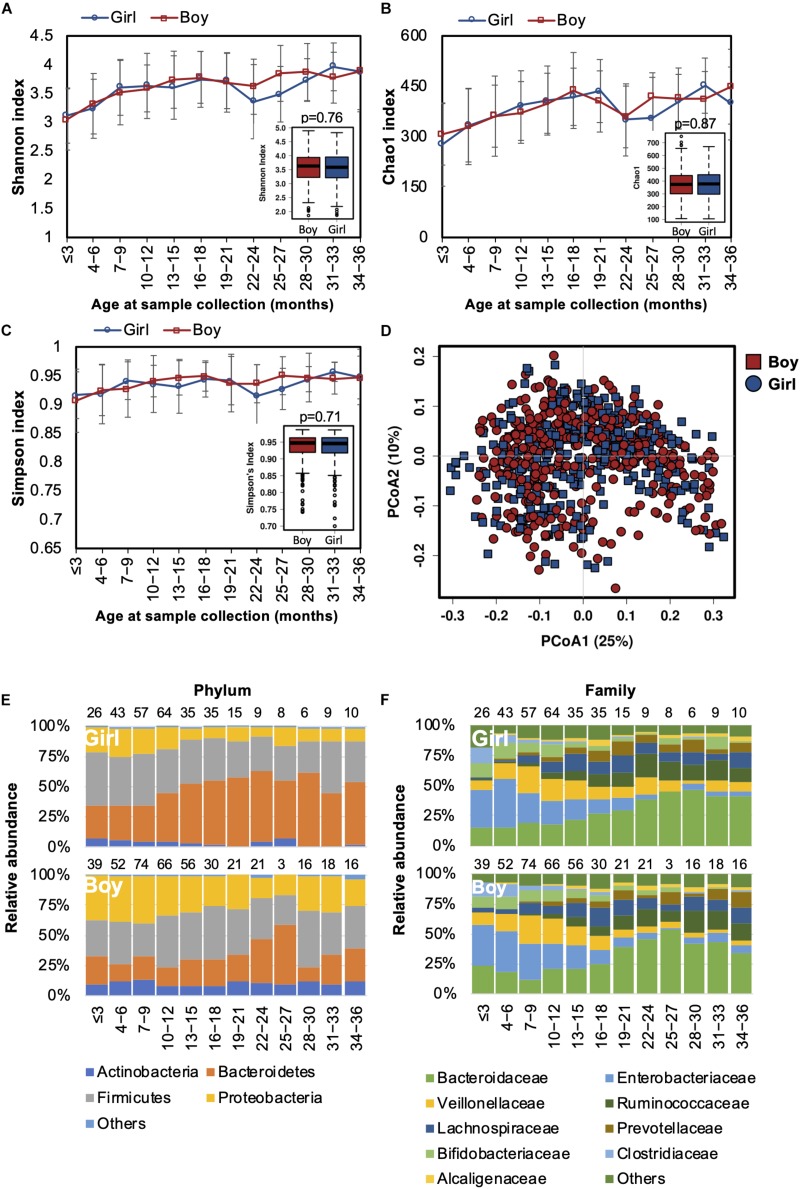
Fecal microbiota diversity and composition for 729 children based on gender. Alpha diversity was calculated with (A) Shannon index, (B) Chao1, or (C) Simpson’s index, and showed no significant difference between genders. (D) PCoA showed no clear separation of the gut microbiota composition between boys and girls. Gender-stratified taxa summary composition of bacterial microbiota at the (E) phylum and (F) family levels. Number of children per age group is provided above bars.